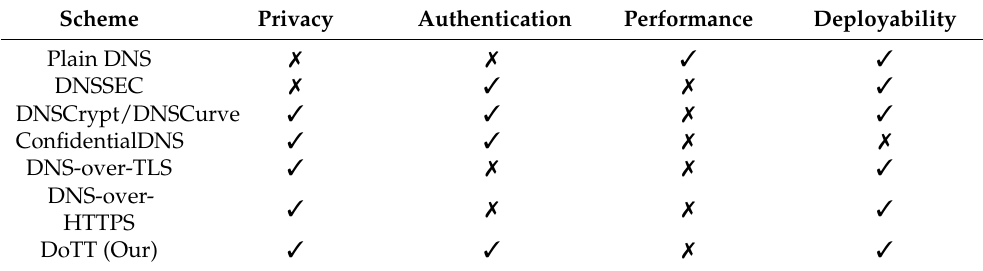
Table 1. Feature comparisons among previous DNS